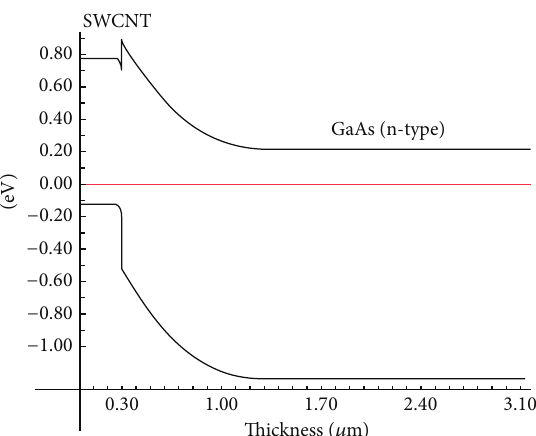
Table 1: The input parameters of AMPS-1D. Figure 2: The energy-band diagram of a typical SWCNT/GaAs solar cell under equilibrium condition. The SWCNT layer has been extended to show better the band diagram.